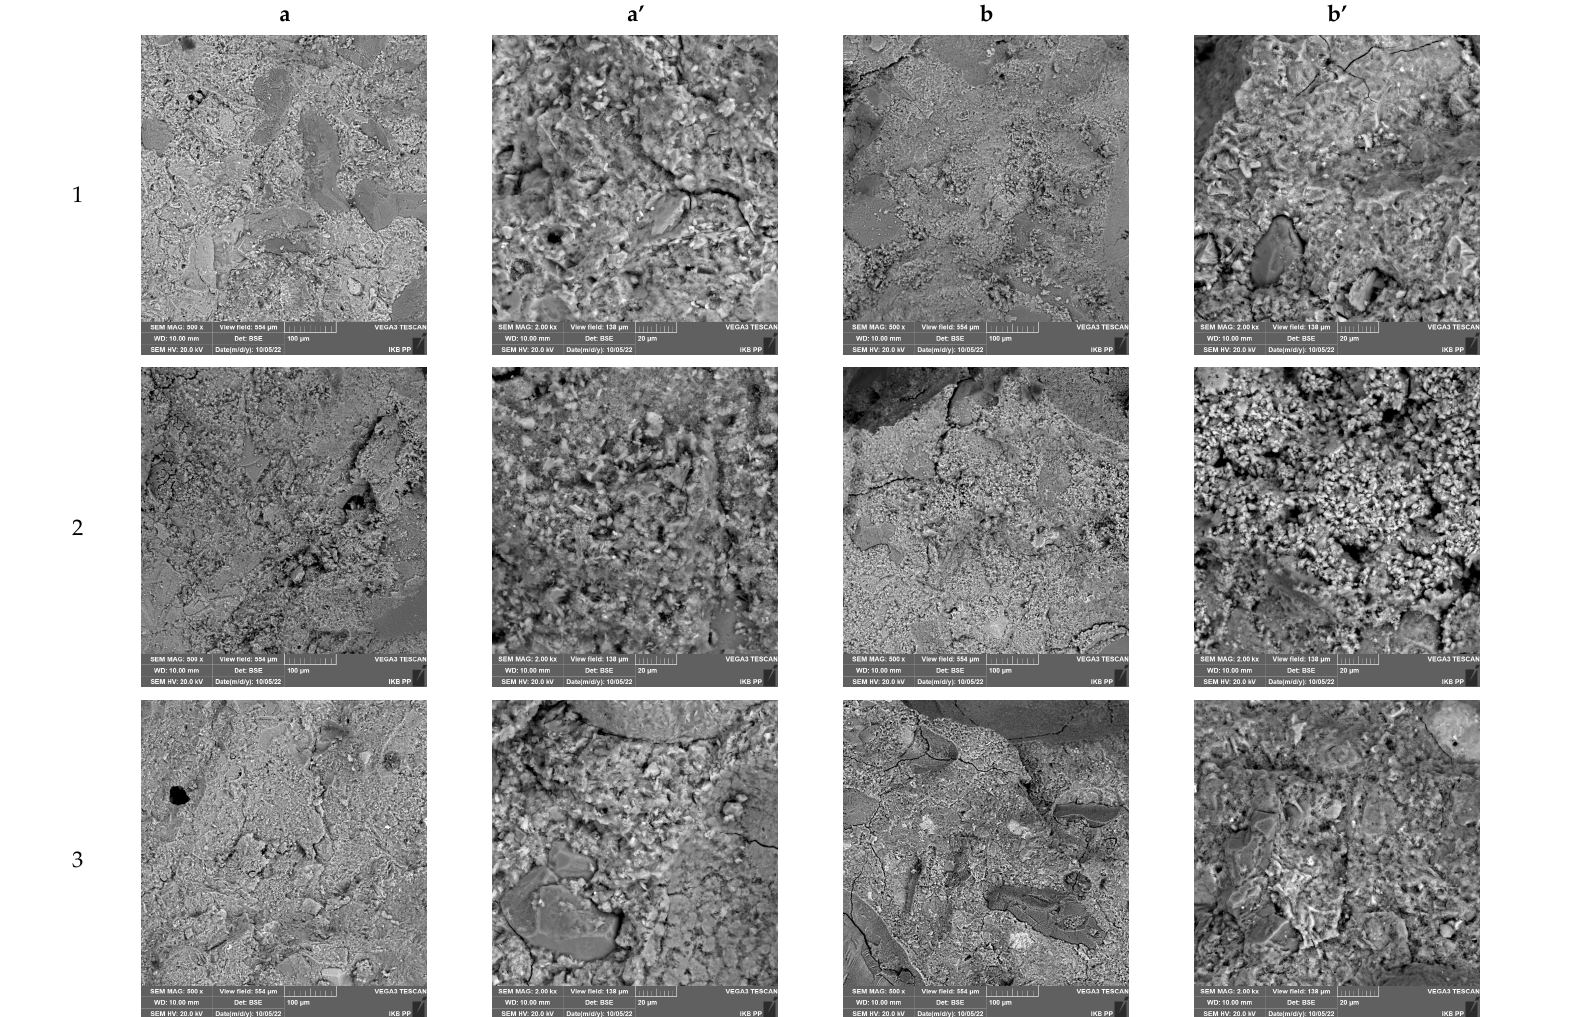
Figure 15. SEM images of cement mortars based on sand and slag and cement CEM 42.5 without freezing–thawing test ( a , a’ ) and after freezing–thawing test ( b , b’